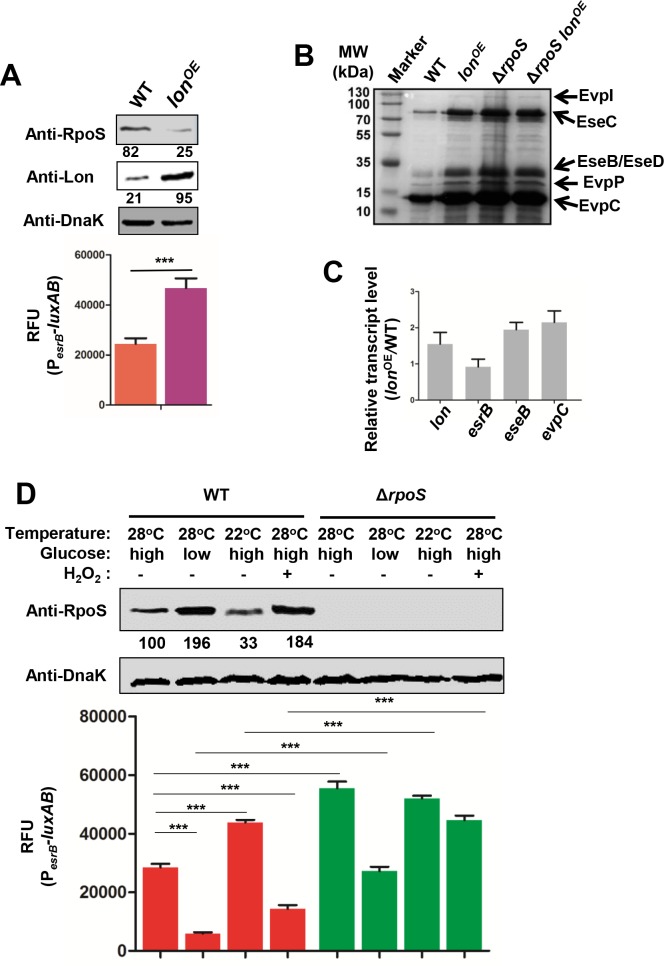
RpoS is regulated by Lon and mediates control of esrB expression in response to environmental stresses.(A) Western blot analysis of RpoS and Lon (top) and expression of PesrB-luxAB in WT and lonOE (Lon over-expression) strains. The results shown are mean ± S.D. (n = 3). ***, P < 0.0001 based on student’s t-test. (B) Extracellular protein profiles of WT, lonOE, ΔrpoS, and ΔrpoS lonOE were separated on SDS-PAGE gels and specific bands corresponding to T3/T6SS proteins are shown. (C) Relative transcript levels of esrB, eseB, and evpC in lonOE vs WT strains (qRT-PCR assays with normalization to gyrB transcript, mean ± S.D. (n = 3). (D) Western blot analysis of RpoS and expression of the esrB promoter in WT and ΔrpoS strains grown in DMEM supplemented with low (1 mg/ml) or high concentrations (4.5 mg/ml) of glucose, with (+) or without (-) addition of H2O2, and at 22°C or 28°C. DnaK was used as the loading control for the blots. The results shown are mean ± S.D. (n = 3). ***, P < 0.0001 based on student’s t-test.